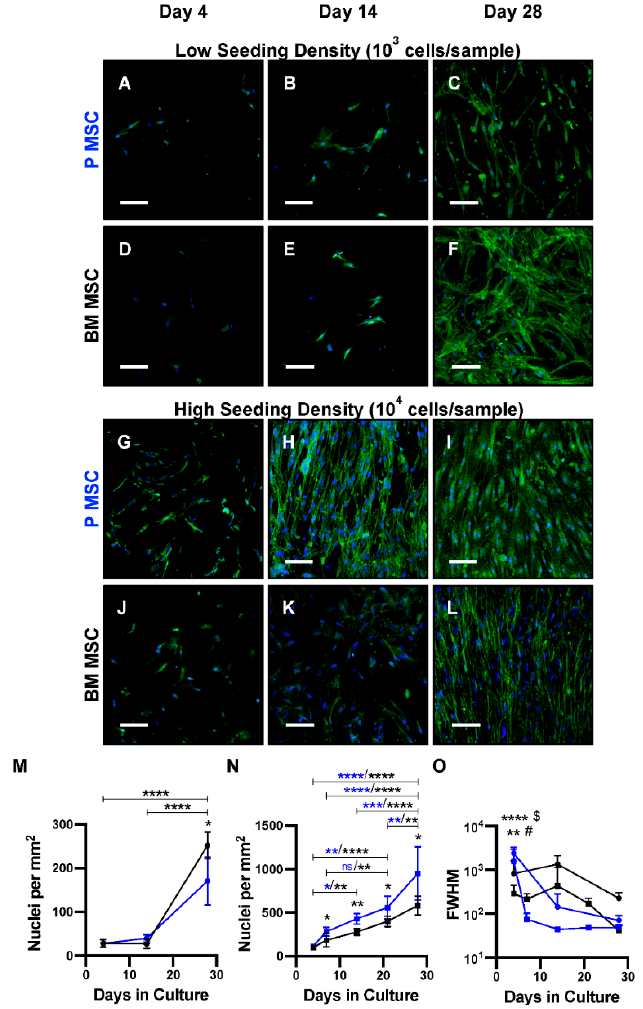
Figure 4. Attachment and proliferation of periosteum (P) and bone marrow (BM) MSCs onto PCL3%-